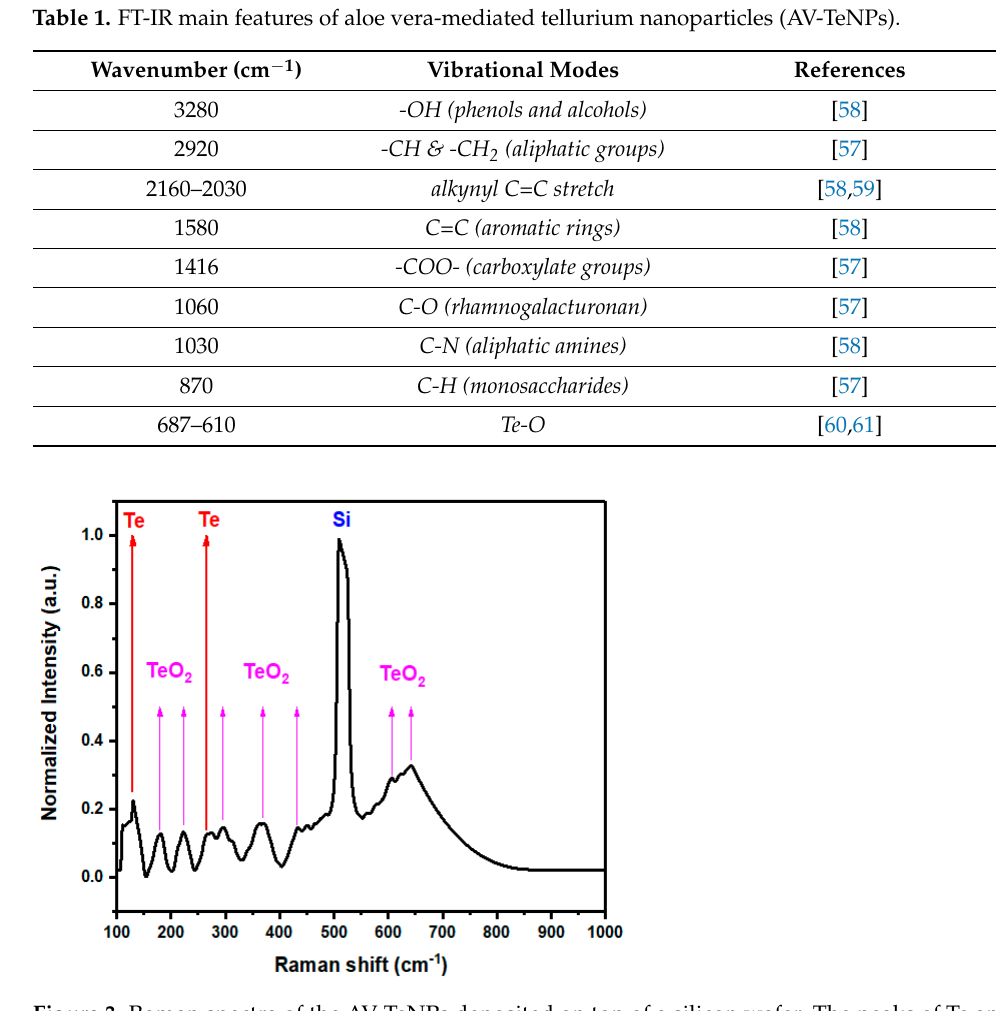
Table 2. Composition of the sample extracted from the broad energy range XPS